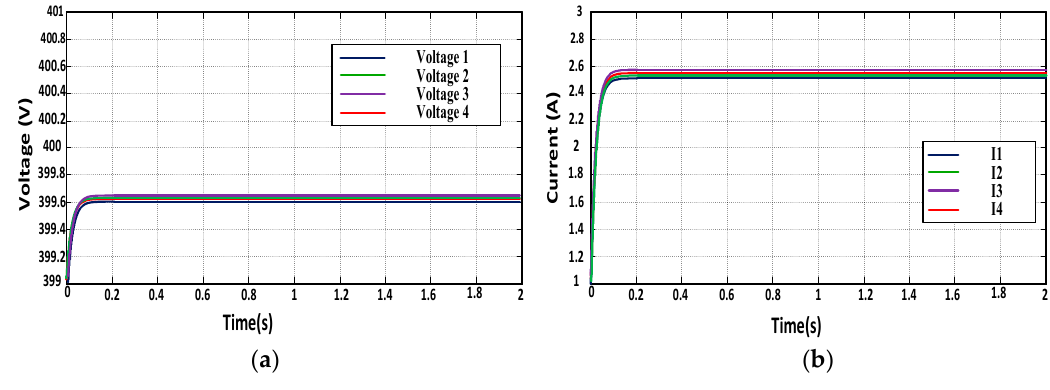
Figure 9. Existing technique [12] with ring communication structure. ( a ) Voltage waveform, ( b ) Current waveforms.